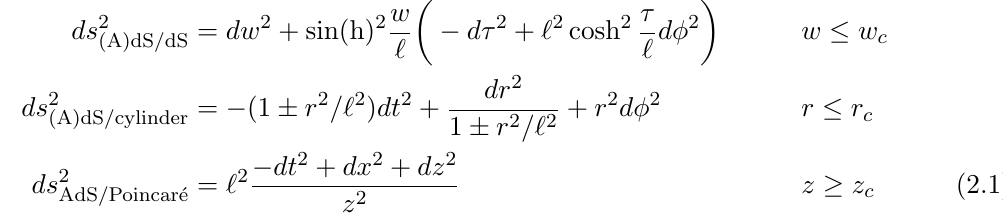
Figure 1 . Patches we will work with depicted in purple within the AdS and dS Penrose diagrams. The top left is dS = dS, with a (cid:12)xed w = w c slice indicated by the dashed line. The purple and orange together cover the full dS/dS patch of dS 3 , while the purple indicates the region that remains after introducing the cuto(cid:11) at a (cid:12)xed w c in the coordinate system (2.1). The top right is dS = cylinder, with again a (cid:12)xed radial position r = r c indicated by the dashed line. The bottom left similarly depicts cut o(cid:11) AdS = dS and the bottom right (a slice of) cut o(cid:11) AdS = Poincar(cid:19)e. The warped metrics for each case in the vacuum state are as